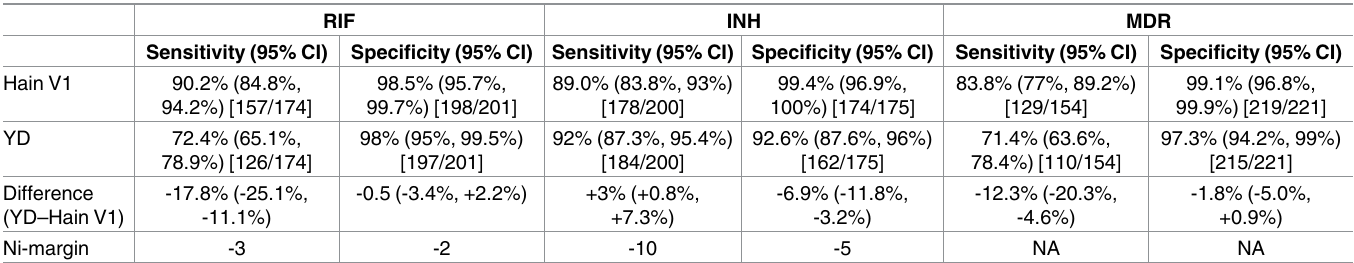
Table 3. Phase 1 comparative accuracyof the YD line probe assay versus Hain V1 line probe assay on characterized strains. RIF